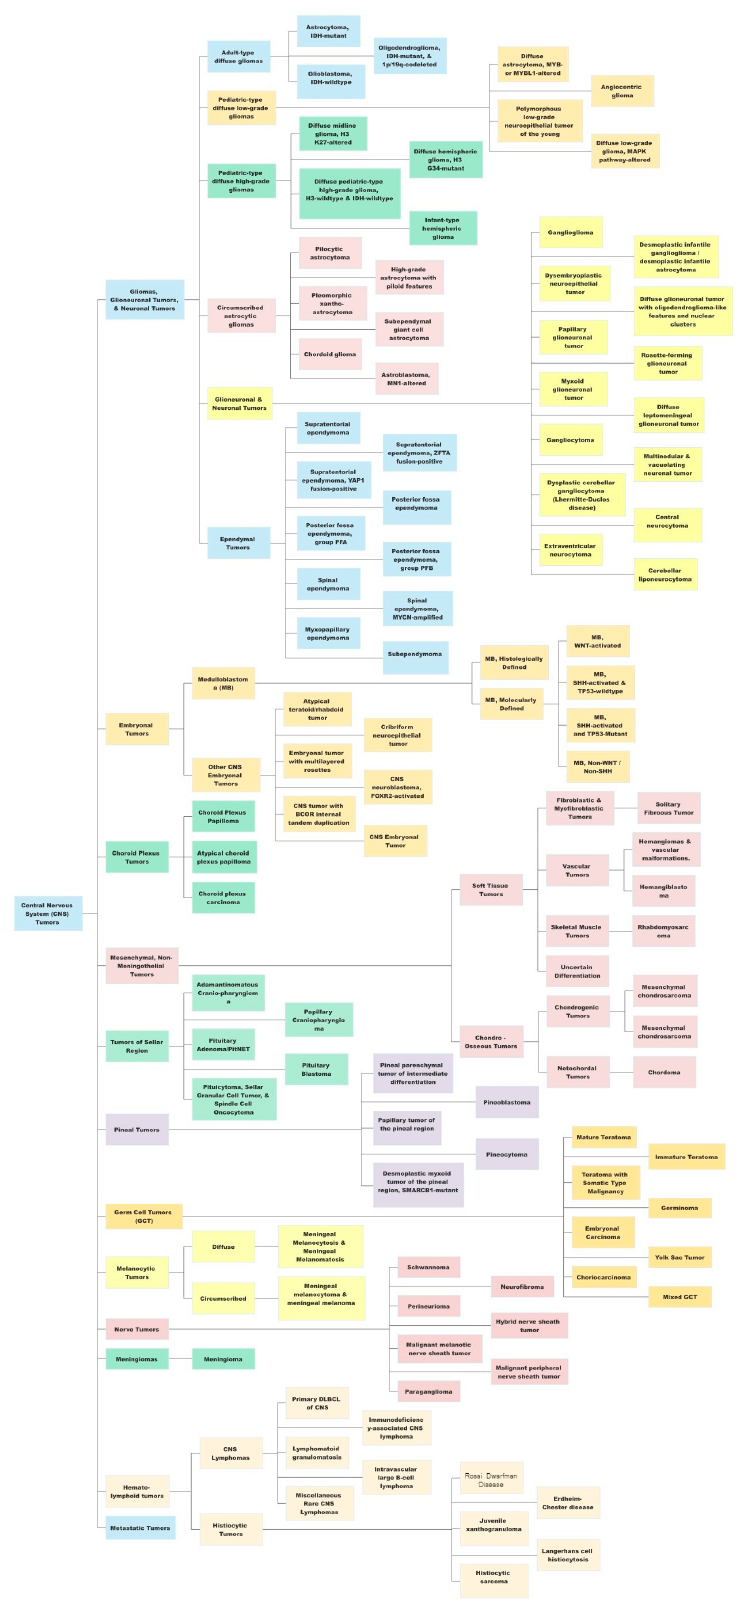
Figure 1. A summary view of the World Health Organization (WHO) 2021 classification of central nervous system (CNS) tumors. This original figure has been created using data available from the WHO CNS5